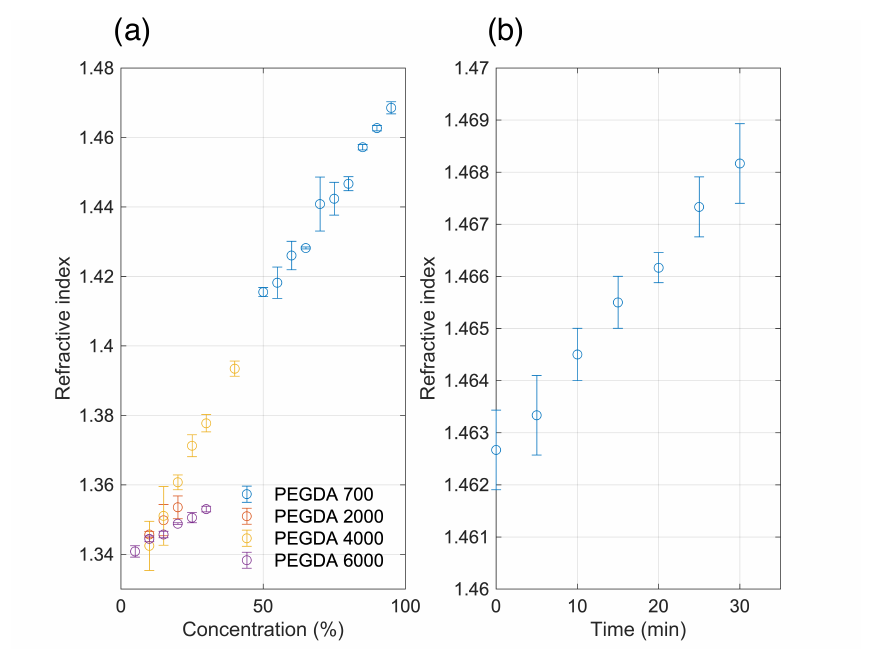
Figure 4. ( a ) Refractive indices of PEGDA hydrogels at different molecular weights and concentrations; ( b ) Refractive index of PEGDA 700, 90% left in air over time. Each data point is an average measurement of n = 3